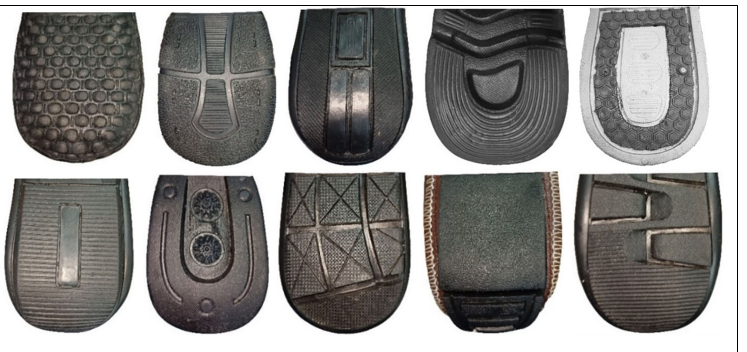
Figure 1. Heel region of the selected Indian formal shoes. Starting from top left (FS1) to bottom right (FS10).